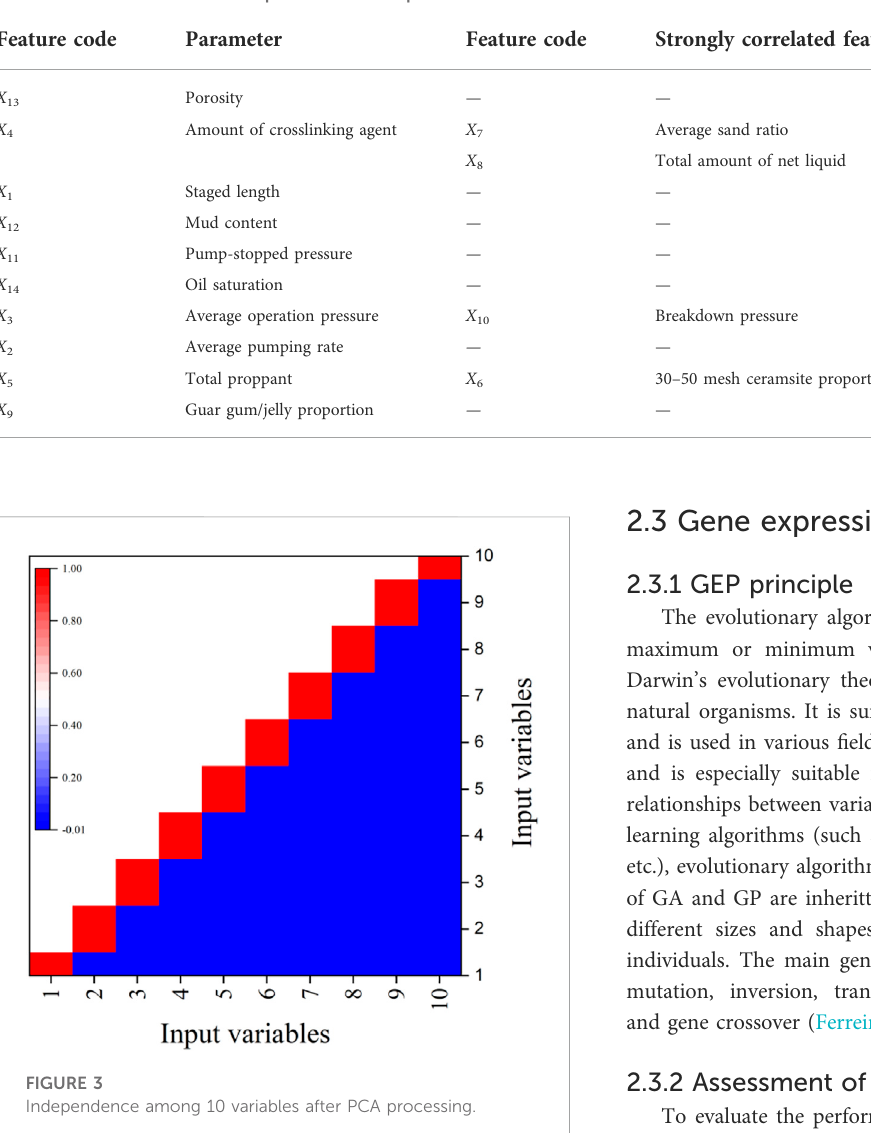
TABLE 3 Reconstruction feature parameter correspondence table.